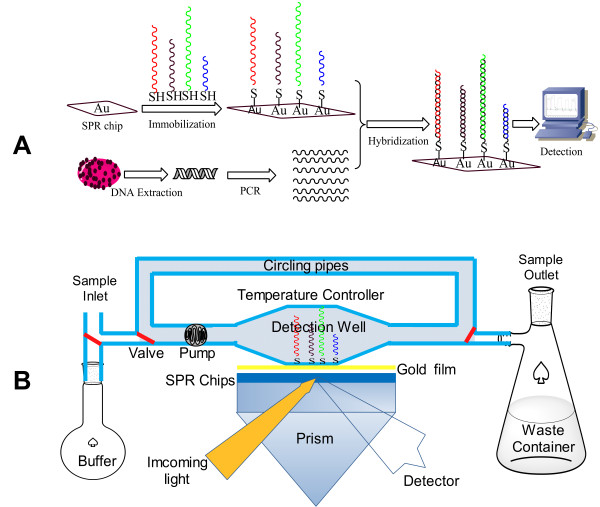
Schematic diagram of detection with SPR biosensor. A) The whole detection procedures include probe immobilization, target nucleic acid extraction and amplification, and detection with SPR biosensor. B) The scheme of SPR detection